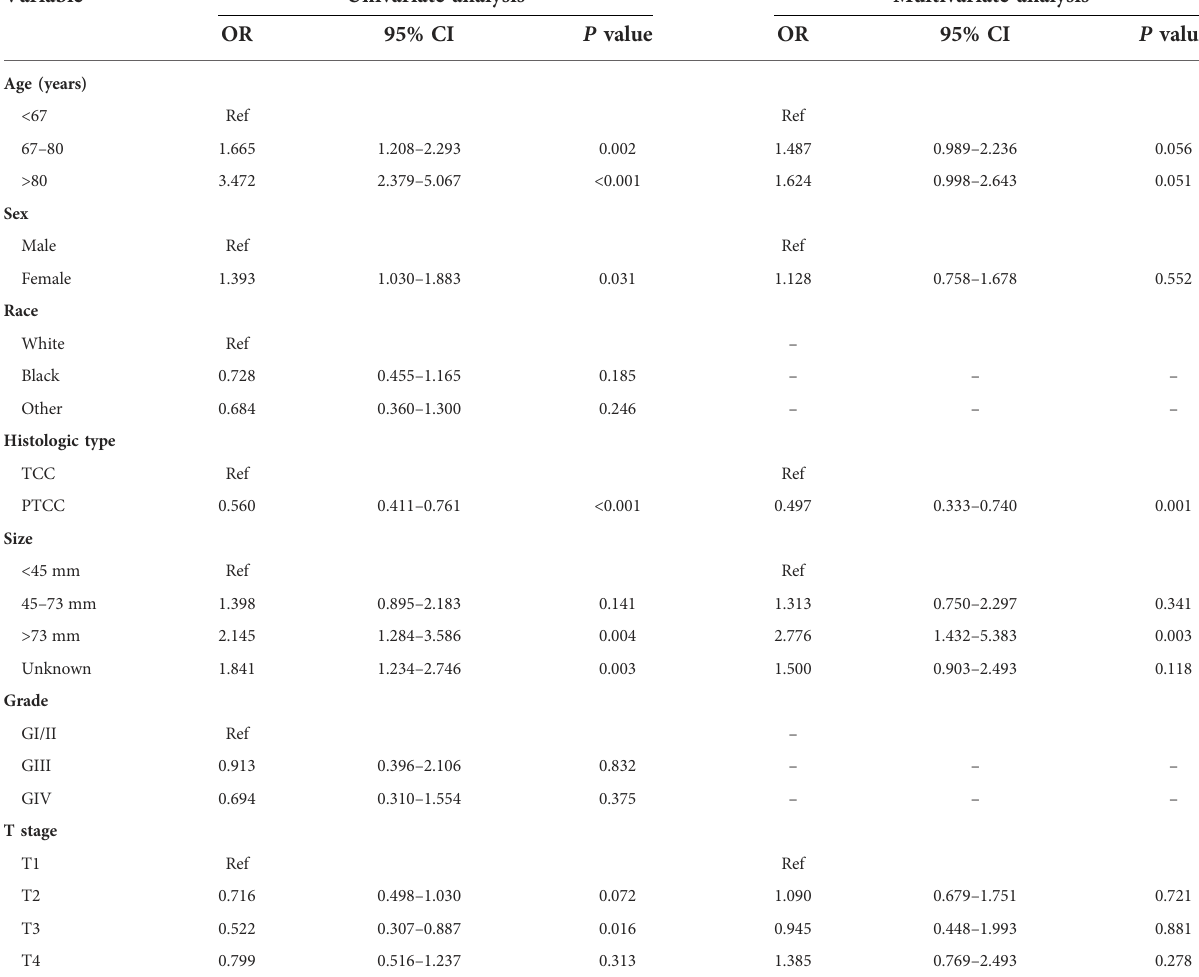
TABLE 2 The univariable and multivariate logistic regression analysis of total early death in the training